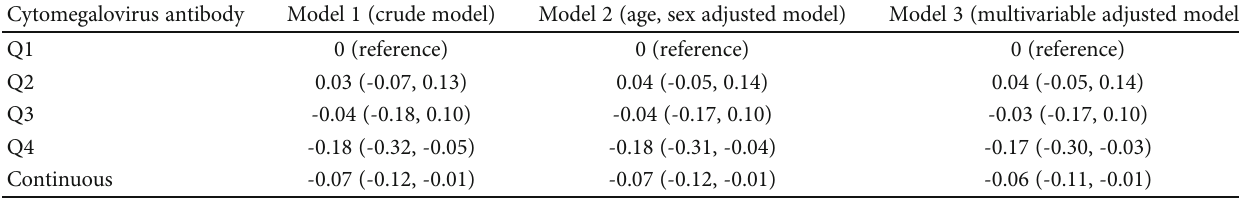
Table 2: Association between cytomegalovirus antibody and telomere length in NHANES.